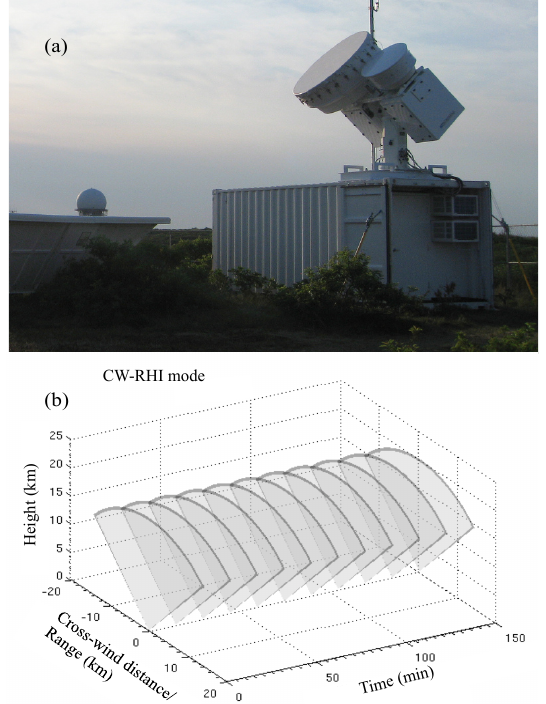
Fig. 1. (a) The Ka/W-SACR at Cape Cod during the ARM mobile facility deployment. A similar system is deployed at the ARM SGP site. (b) Schematic of the CW-RHI scan strategy.